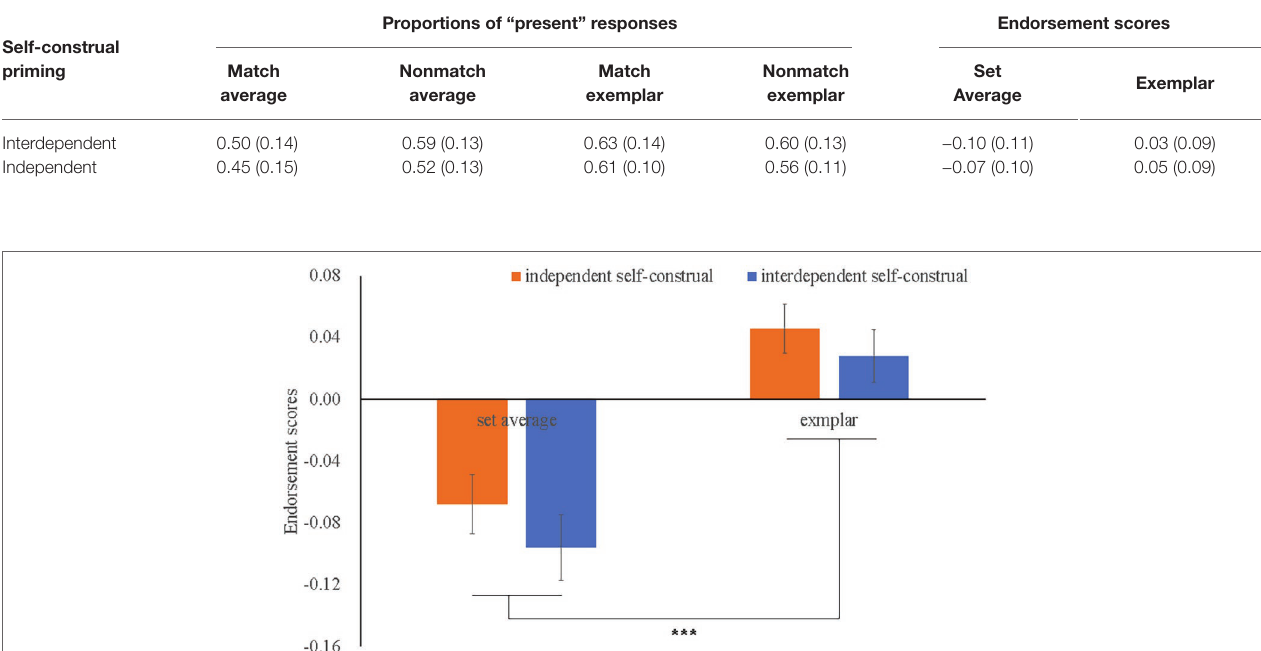
TABLE 2 | Descriptive data of experiment 2.